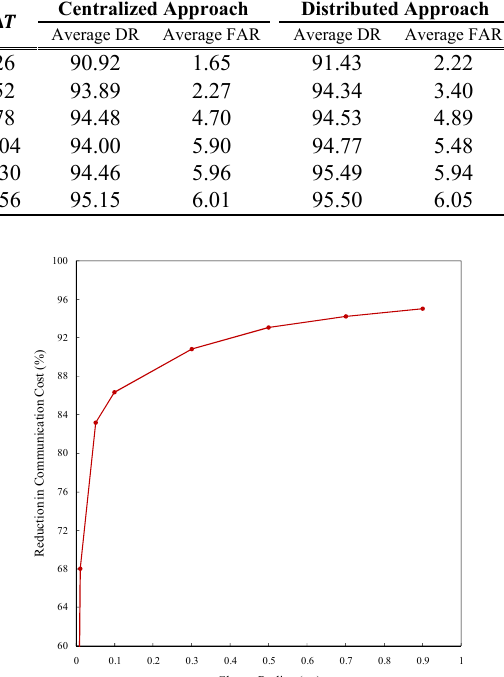
Figure 10. Reduction in communication overhead in the network for different values of (cid:2205) (cid:2185) .